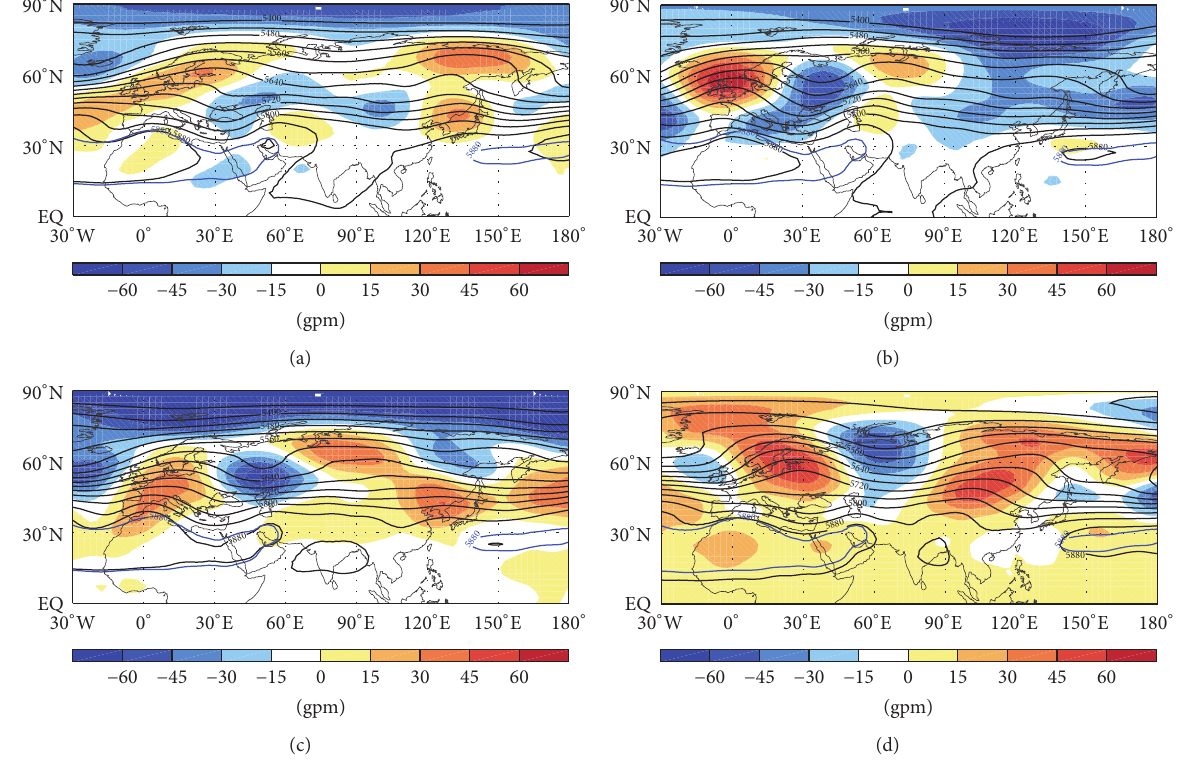
Figure 13: 500 hPa GPH (contour) and its corresponding anomalies (shading) (units: gpm) of the SFND pattern in the summers of (a) 1973, (b) 1976, (c) 1994, and (d) 2002; blue lines denote the climatology of 5880 gpm.